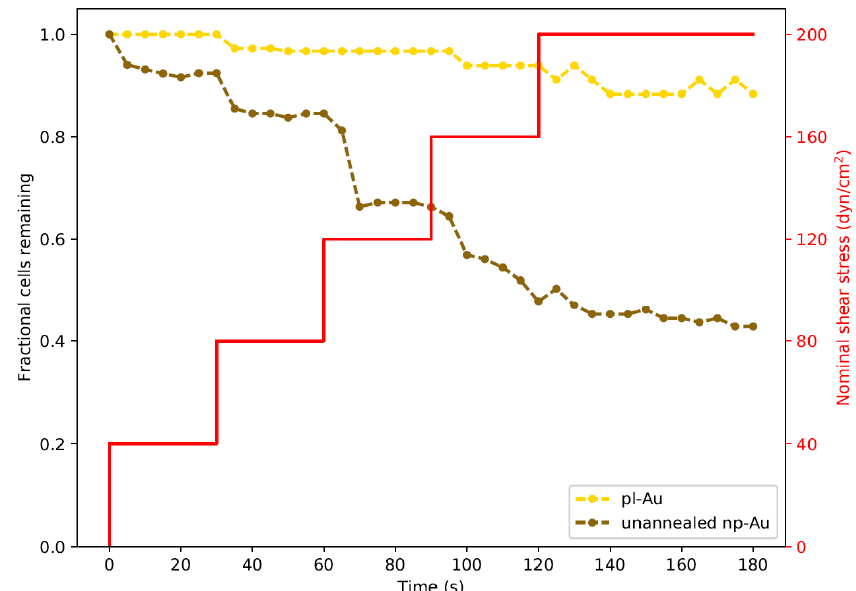
Figure 4. Real-time monitoring of cell detachment (surrogate for adhesion strength) as a function of increasing shear stress. Cells were subjected to increasing levels of shear stress as shown by the red staircase curve. Images were taken every 5 s. Two trials were performed for each morphology and were plotted as averages. Each data point for fractional cells remaining was normalized to the cell count at the start of each experiment.